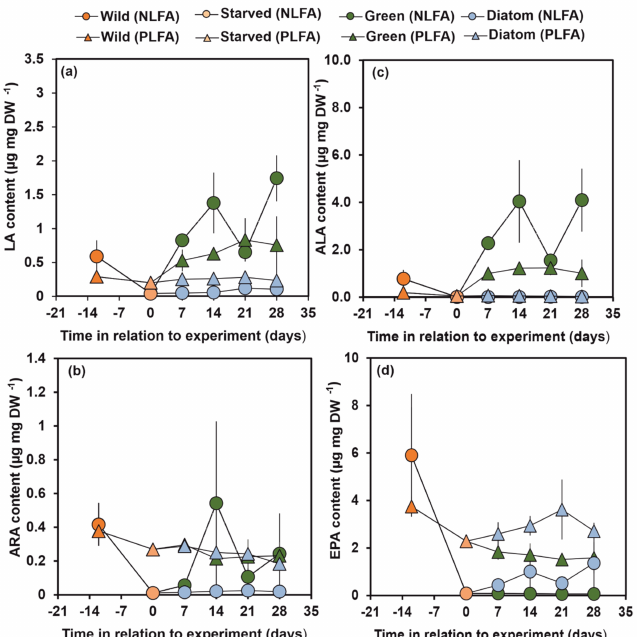
Figure 4. ( a ) LA, ( b ) ALA, ( c ) ARA, and ( d ) EPA content of Pallaseopsis quadrispinosa in PLFA and NLFA fraction in wild (day − 12), starved (day 0) and in green algae ( Acutodesmus sp.) and diatom ( Diatoma tenuis ) experiments. Day cites to the age of initial wild amphipods ( − 12) in relation to the start (day 0, starved 12 days) of the experiment